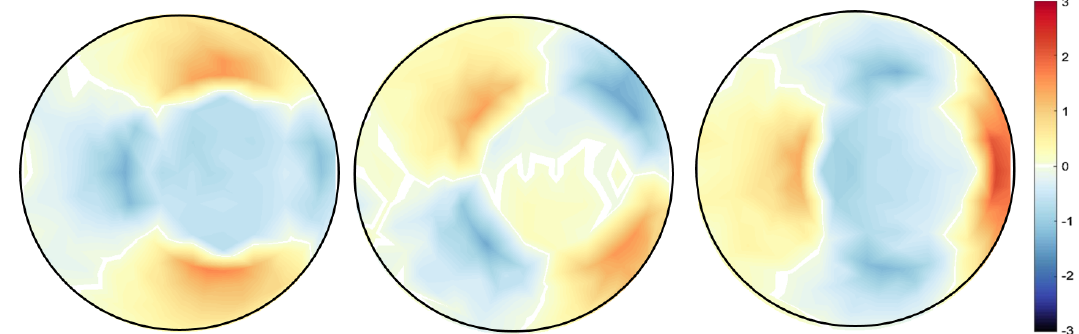
Figure 9. Ring-and-plug strain images obtained from KOWARI